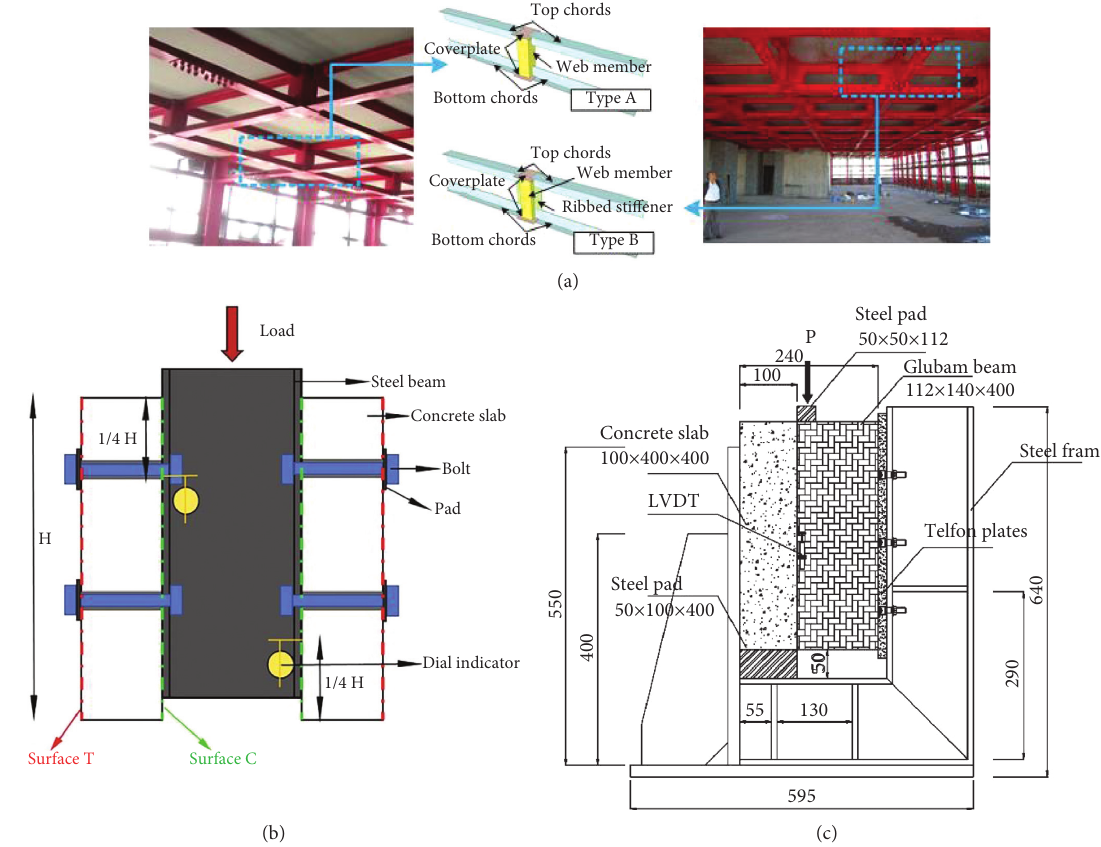
Figure 2: The structures in reference. (a) The steel structure in [6]. (b) The steel-concrete composite structure in [7]. (c) The wood-concrete composite structure in